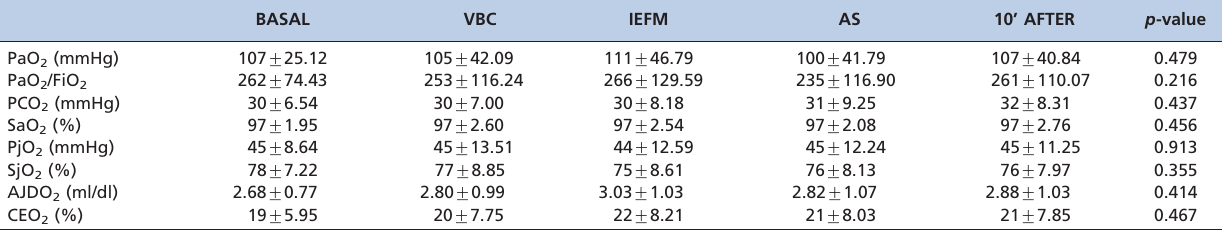
Table 3 - The results of the blood gas variables, reported as means and standard deviations. BASAL VBC IEFM AS 10’